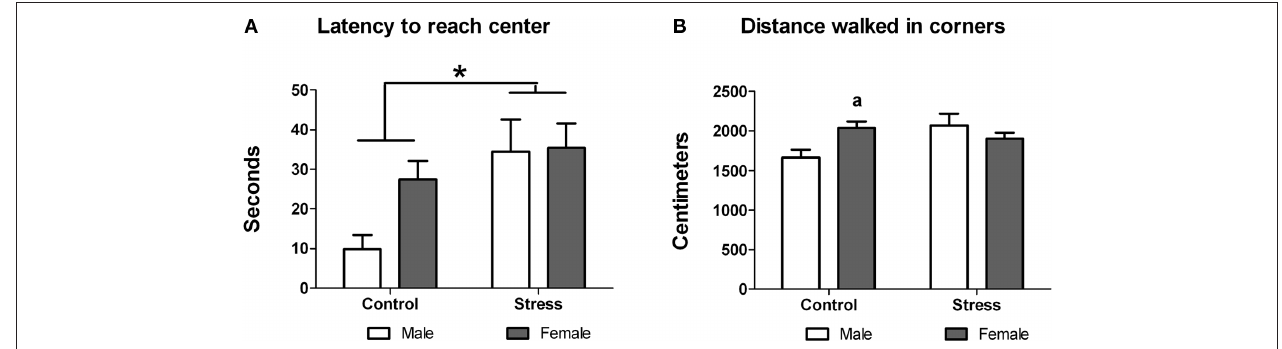
Figure 2 | effect of peri-pubertal stress on behavior at the open field test. Mean (SEM) behavioral measures in the open field test for male and female rats that underwent either peri-pubertal stress (Stress) or no stress (Control). (a) Latency to reach center and (B) distance walked in corners. * p < 0.05 treatment effect; a p < 0.05 post hoc comparison between control male and females.